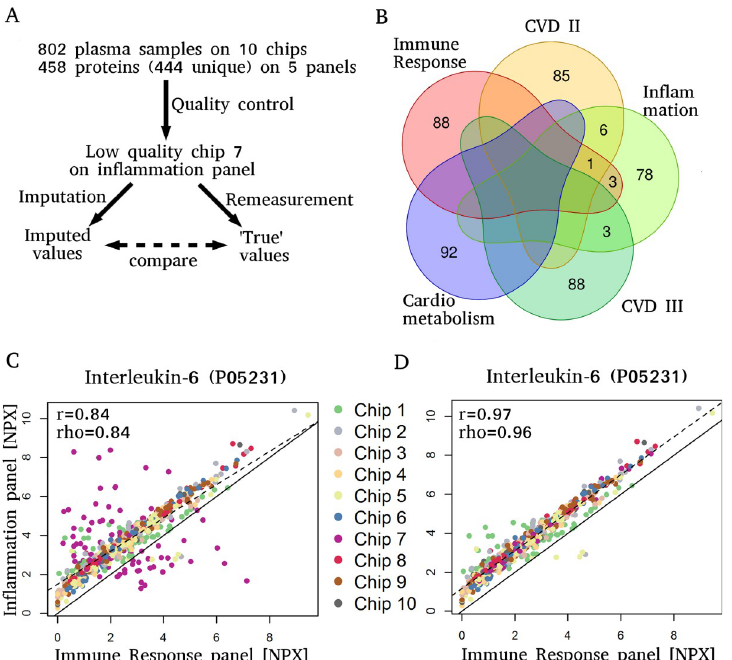
Fig 1. Real case scenario. A) Outline of the case scenario for evaluation of imputation results. 802 plasma samples from 645 patients were originally measured on 10 protein expression chips per protein panel. A total of 458 proteins (444 unique proteins) were measured on the 5 panels. During quality control, one chip (out of ten chips) on the inflammation panel (chip number 7) was identified to be of low quality. This chip was imputed and subsequently remeasured for evaluation, allowing for direct comparison of imputed versus remeasured values. B) Venn diagram representing the number of unique proteins as well as the overlap of protein sets measured by each of the 5 PEA panels. C) NPX values from IL-6 on the immune response panel versus the inflammation panel, revealing a malfunctioning inflammation chip (chip No. 7). D) Remeasurement of chip No. 7 resolved the quality